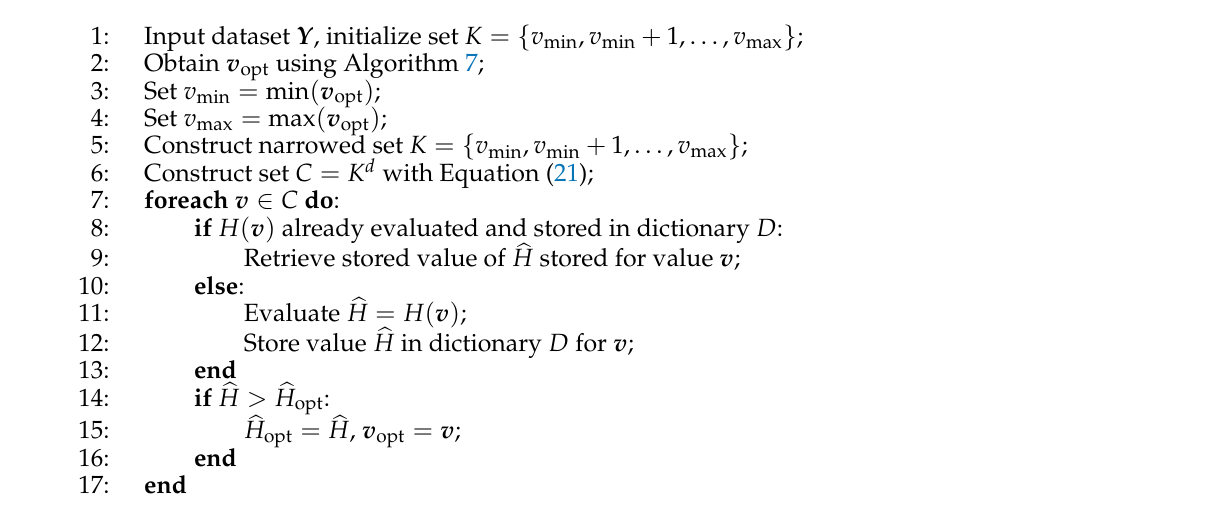
Algorithm 8: Narrowed exhaustive search with a coordinate-descent algorithm for optimum histogram binning v with